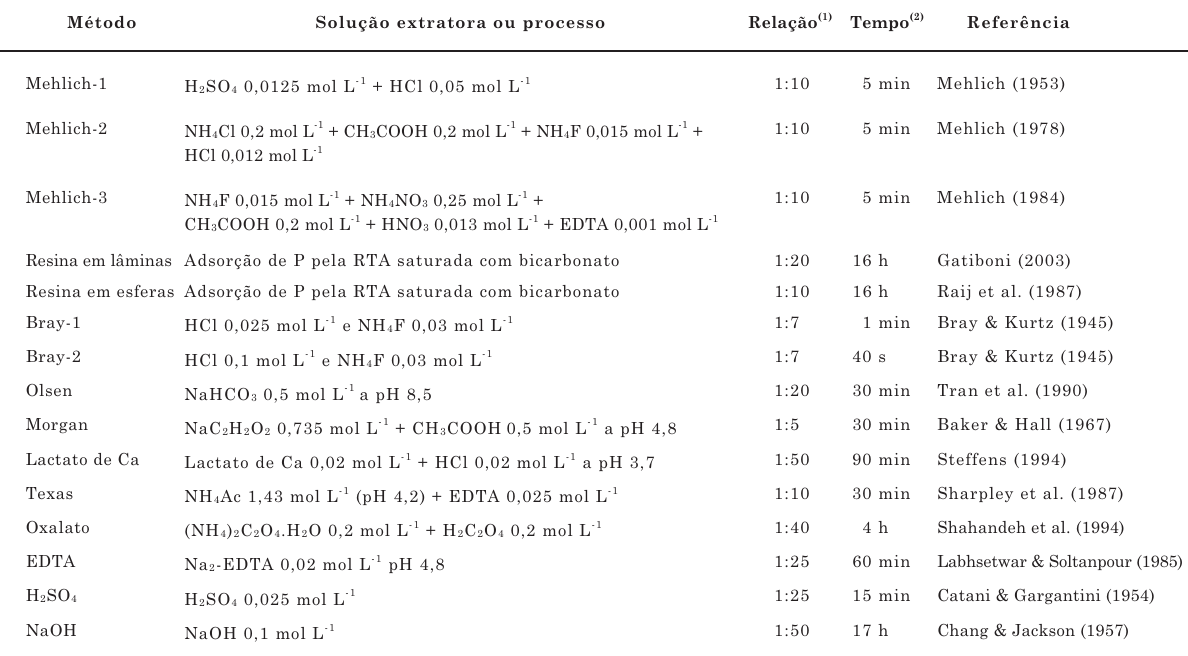
Resina em lâminas Adsorção de P pela RTA saturada com bicarbonato Resina em esferas Adsorção de P pela RTA saturada com